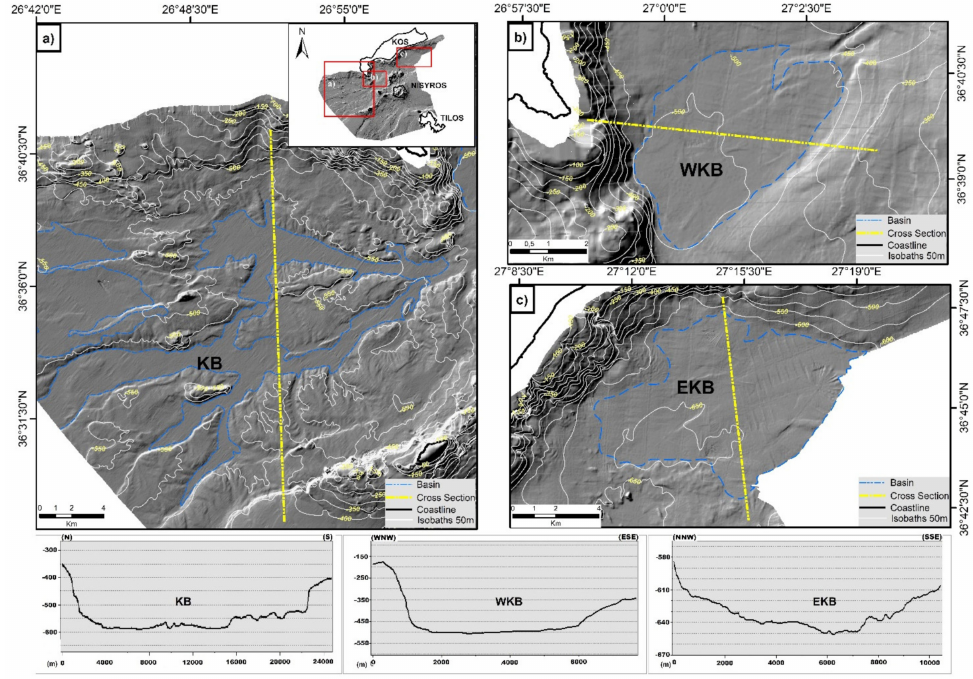
Figure 5. Location of the three main submarine basins of the study area ( a ) Kondeliousa Basin (KB), ( b ) Western Kos Basin (WKB) and ( c ) Eastern Kos Basin (EKB) according to swath bathymetric data. Depth profiles of each basin are also illustrated according to their selected